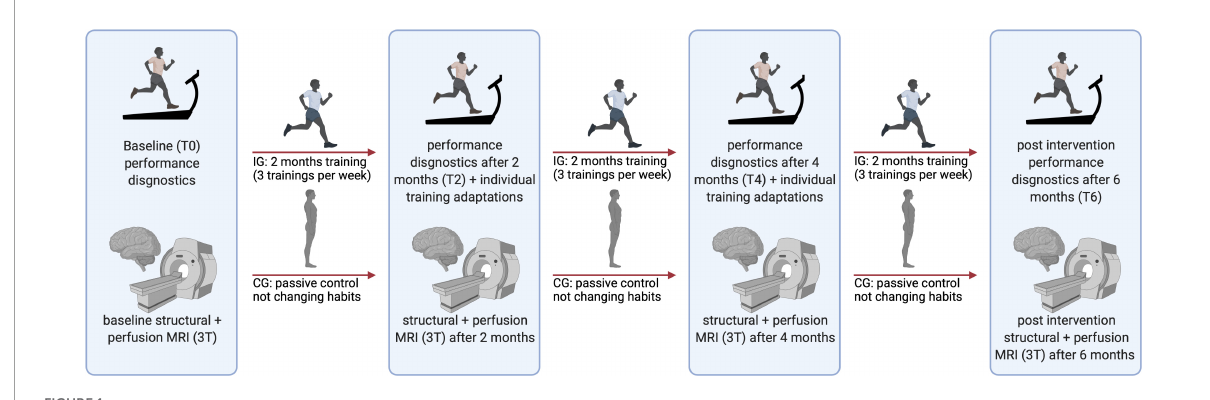
FIGURE1 Flow diagram of the study showing examinations at each time point (T0, T2, T4, and T6). 3T, 3 Tesla; MRI, magnetic resonance imaging; CG, control group; IG, intervention group. Figure was created with BioRender.com.